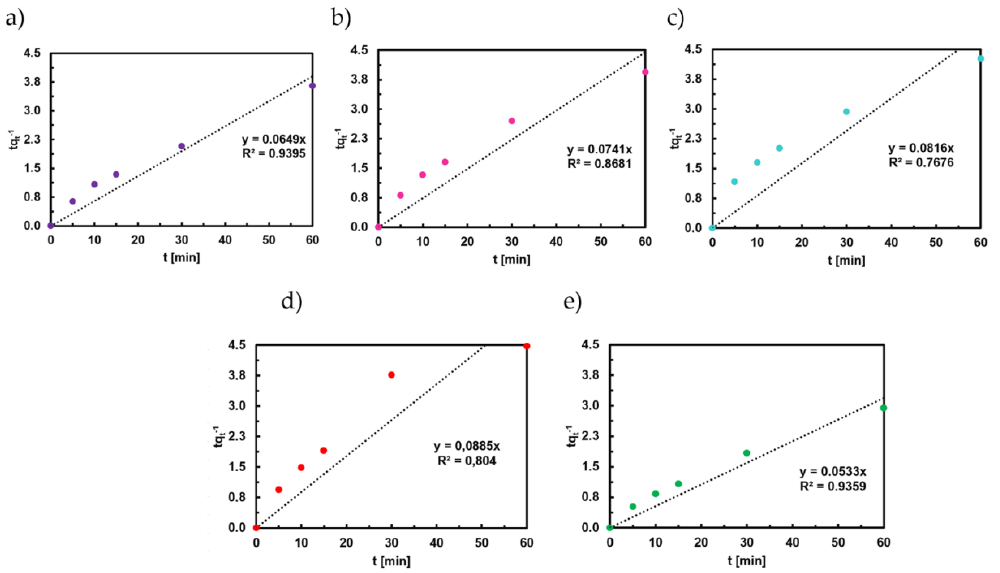
Figure 10. Adsorption data modeled using kinetic McKay and Ho’s pseudo-second-order law for ( a ) Fe 3 O 4 , ( b ) Fe 3 O 4 @1%Zn, ( c ) Fe 3 O 4 @2%Zn, ( d ) Fe 3 O 4 @5%Zn, and ( e ) Fe 3 O 4 @10%Zn nanoparticles.